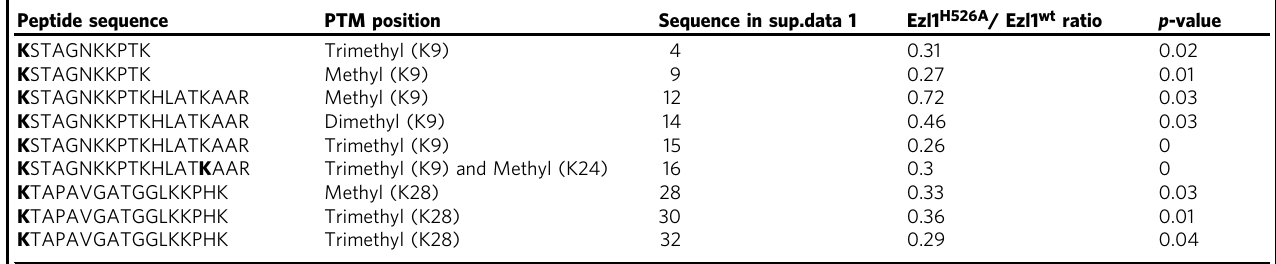
Table 1 Quantitative label-free mass spectrometry analysis of Paramecium histone H3 Peptide